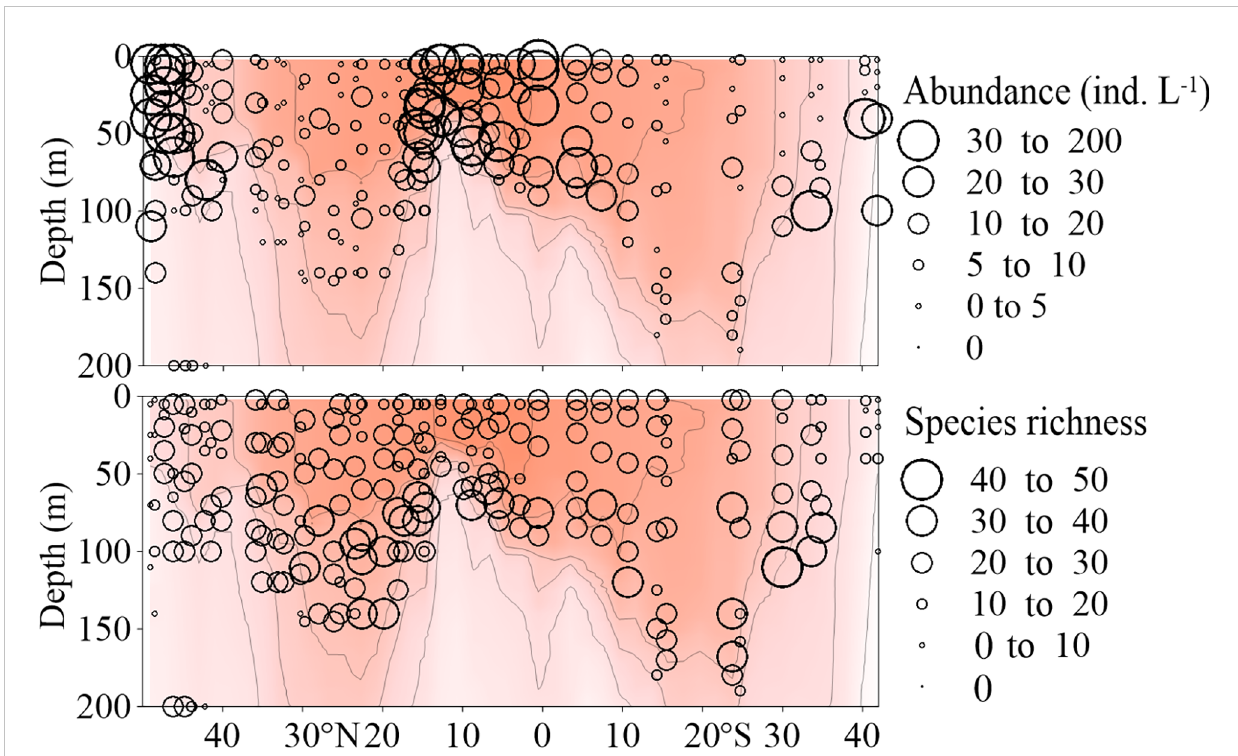
FIGURE 7 Vertical distribution of Tintinnina abundance (ind. L -1 ) and species richness along the AMT transect. The red color and isothermal lines are temperature (°C) as in Figure 2. Black dots denote the locations of sample